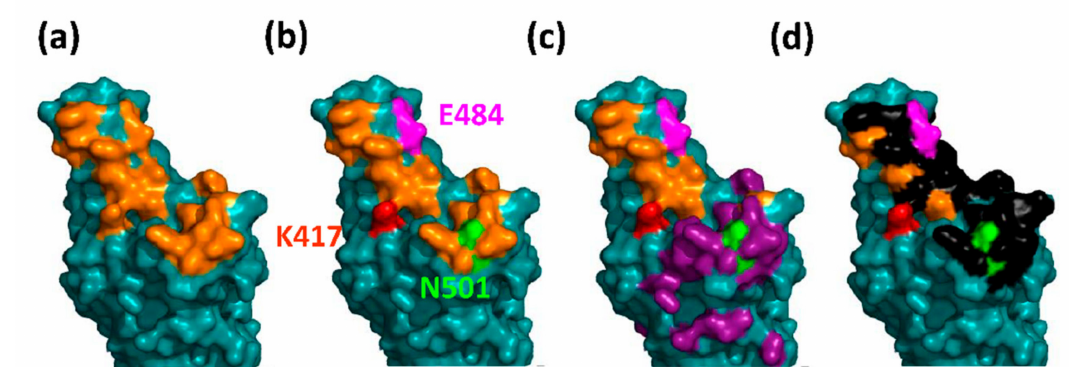
Figure 7. The structural plasticity of the hAce2 binding site in Spike. ( a ) The surface of the hAce2 binding site of the Wuhan strain is shown in all subpanels. The 17 amino acids making direct contact with hAce2 are highlighted in orange; ( b ) the positions of the mutations K417T/N (red), E484K (magenta), and N501Y (green) present in the Brazilian P.1 and the South African B.1.351 Spike proteins are highlighted; ( c ) the epitope of the neutralising antibody M369 is shown in dark purple; ( d ) the epitope of the neutralising antibody 80R is shown in black [9]. Please note that N501 resides within both epitopes. Hence, its mutation enhances hAce2 affinity while simultaneously impairing antibody binding. Images were rendered with PyMOL (Molecular Graphics System, Version 2.0 Schrödinger, LLC); the structure file was generated with Phyre2 (Protein Homology/analogy Recognition Engine V 2.0) using the Wuhan Spike protein sequence: UniProt